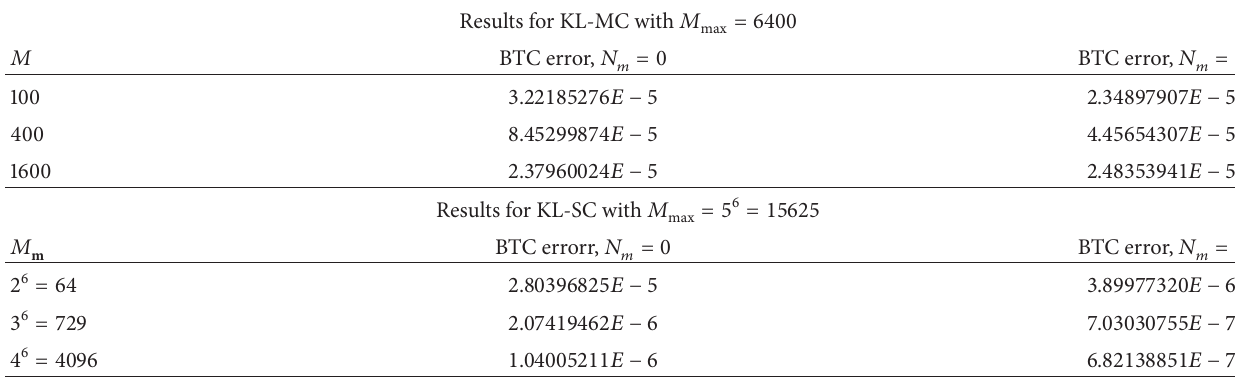
Table 4: Stochastic convergence for transport results unconditional KL-MC method. Errors are reported against the solution obtained with 𝑀 = 6400 MC realizations. Results for KL-MC with 𝑀 max =